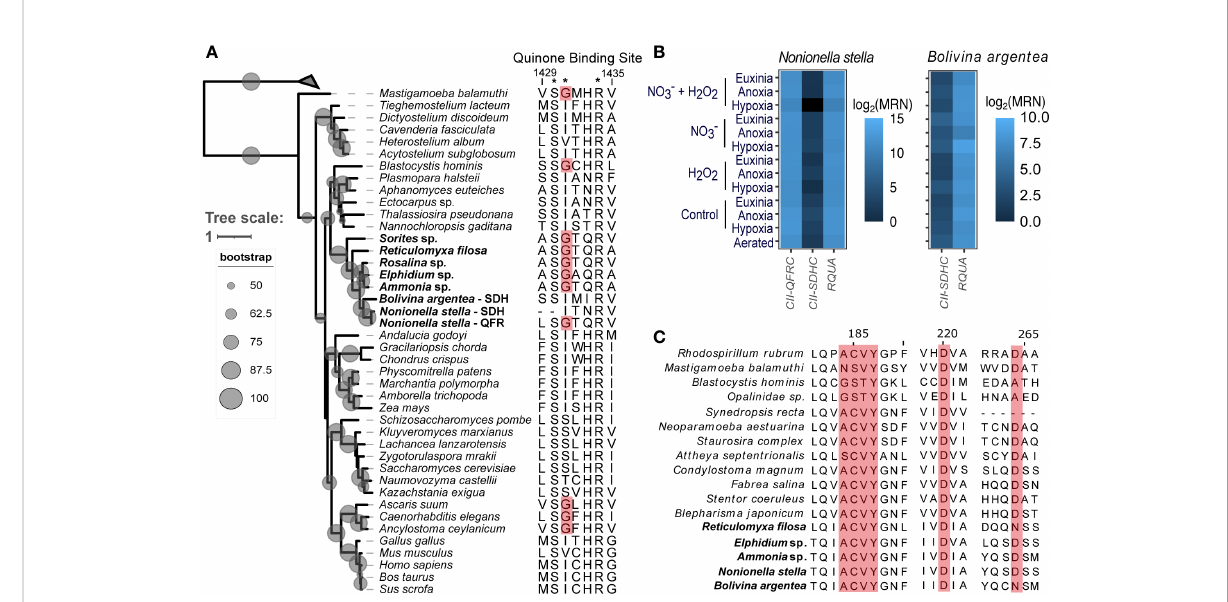
FIGURE 4 (A) Phylogenetic reconstruction of concatenated protein sequences from Complex II showing phylogenetic placement of the putative CII-QFR and CII-SDH from N. stella and B. argentea , with bootstrapping support values represented as scaled, gray-shaded circles. This phylogeny is rooted using bacterial fumarate reductase sequences. Leaves belonging to foraminifera are highlighted with bold font. The amino acid sequences to the right of the tree shows an alignment of the quinone-binding site in the CII large cytochrome C subunit. Asterisks indicate amino acids implicated in quinone binding. Sites highlighted in red background are QFR-speci fi c mutations associated with the binding of rhodoquinone. (B) Expression of the CII-QFRC , CII-SDHC , and RQUA genes of N. stella and/or B . argentea represented as a heatmap for each species based on the log 2 transformed median ratio normalization (MRN) values. (C) Multiple sequence alignment of the RQUA protein from foraminifera and other eukaryotes. Amino acid residues highlighted in red background indicate functional sites in the quinone-binding pocket. Sequences belonging to foraminifera are labeled with bold